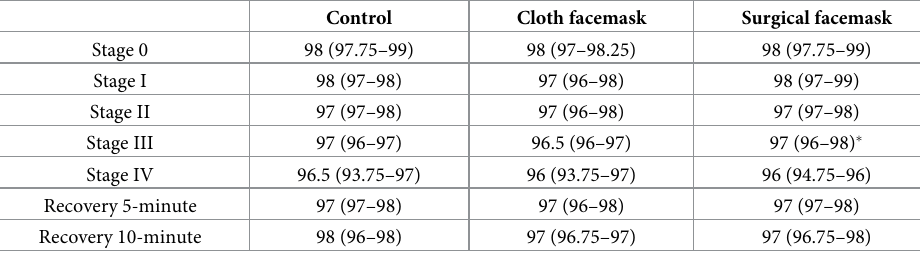
Table 1. Changes in SpO 2 before, during and after the treadmill walking test.